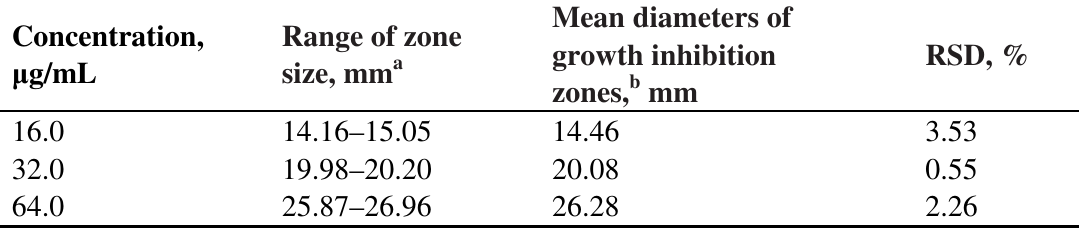
Table 1. Diameters of growth inhibition zones for orbifloxacin reference substance solutions obtained for standard